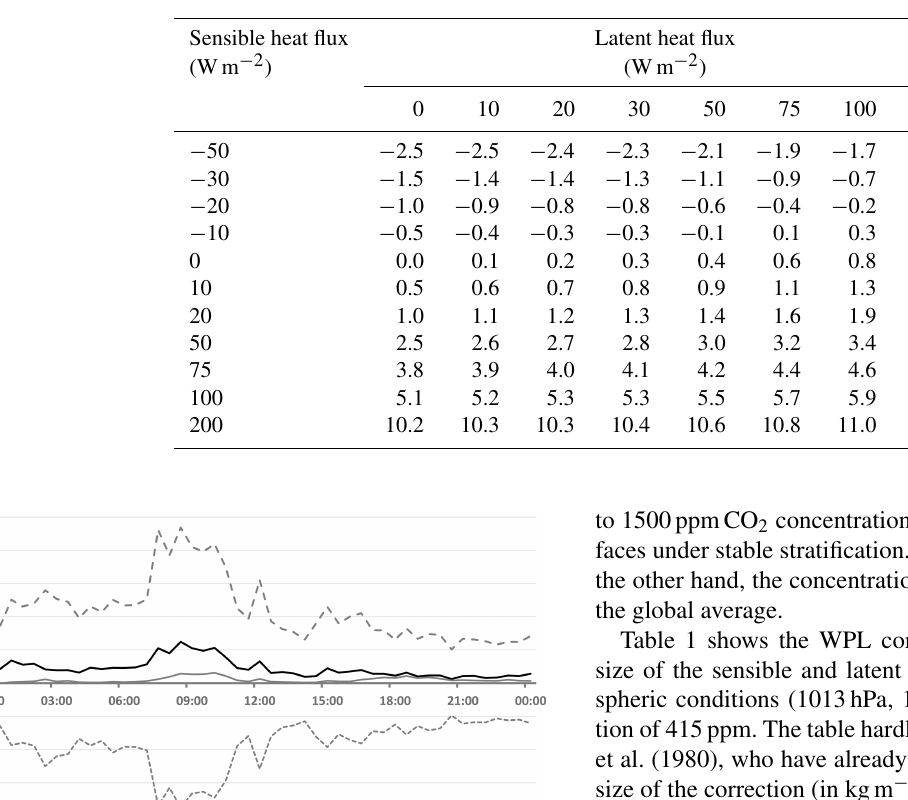
Table 1. WPL correction (in µmolm − 2 s − 1 ), using the second and third term of Eq. (1), as a function of sensible and latent heat flux for standard atmospheric conditions (1013hPa, 15 ◦ C), a CO 2 concentration of 415ppm, and 100% relative humidity. At lower humidity values, the correction factor is a few percent lower in terms of the sensible heat flux.